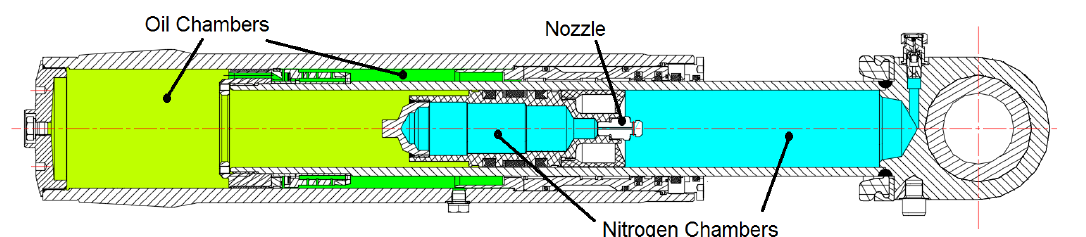
Figure 1. Scheme of a typical heavy vehicle